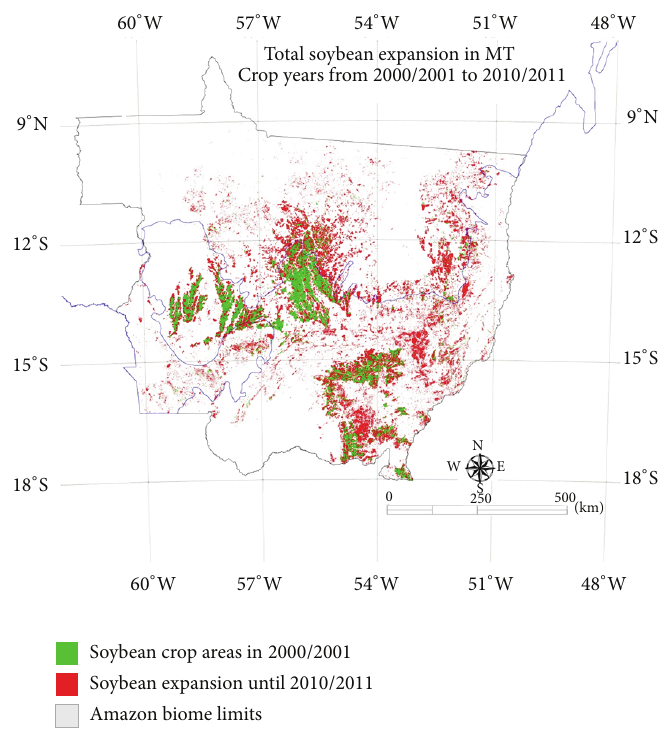
Figure 6: Total soybean crop area expansion in Mato Grosso state after